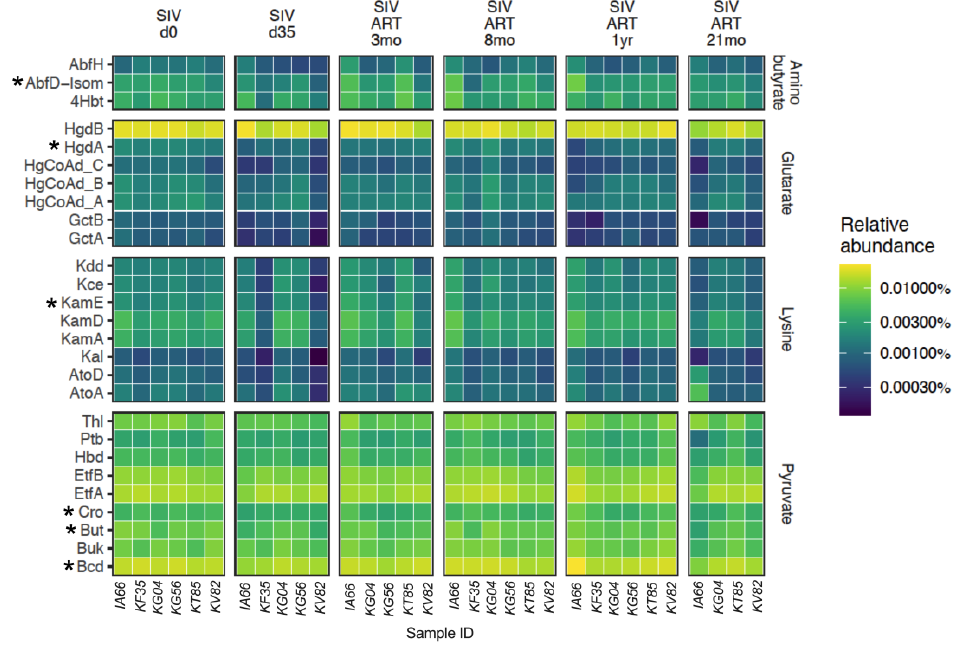
Figure 5. Changes in butyrate producing genes. The change in relative abundance of genes in four pathways responsible for butyrate production as curated by Vital et al. [42]. Rows represent individual genes, and the columns represent indi- vidual animals at each study time-point. Asterisks represent if the gene shows a statistically significant linear decrease through SIV infection and ART based on linear mixed effects models. The final time-point of 21 mo ART has only four animals since two of the study animals were euthanized at the 18 mo ART